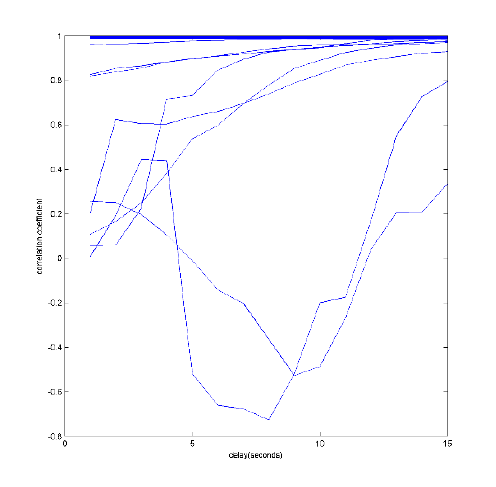
Figure 5. Asynchronous correlation coefficient